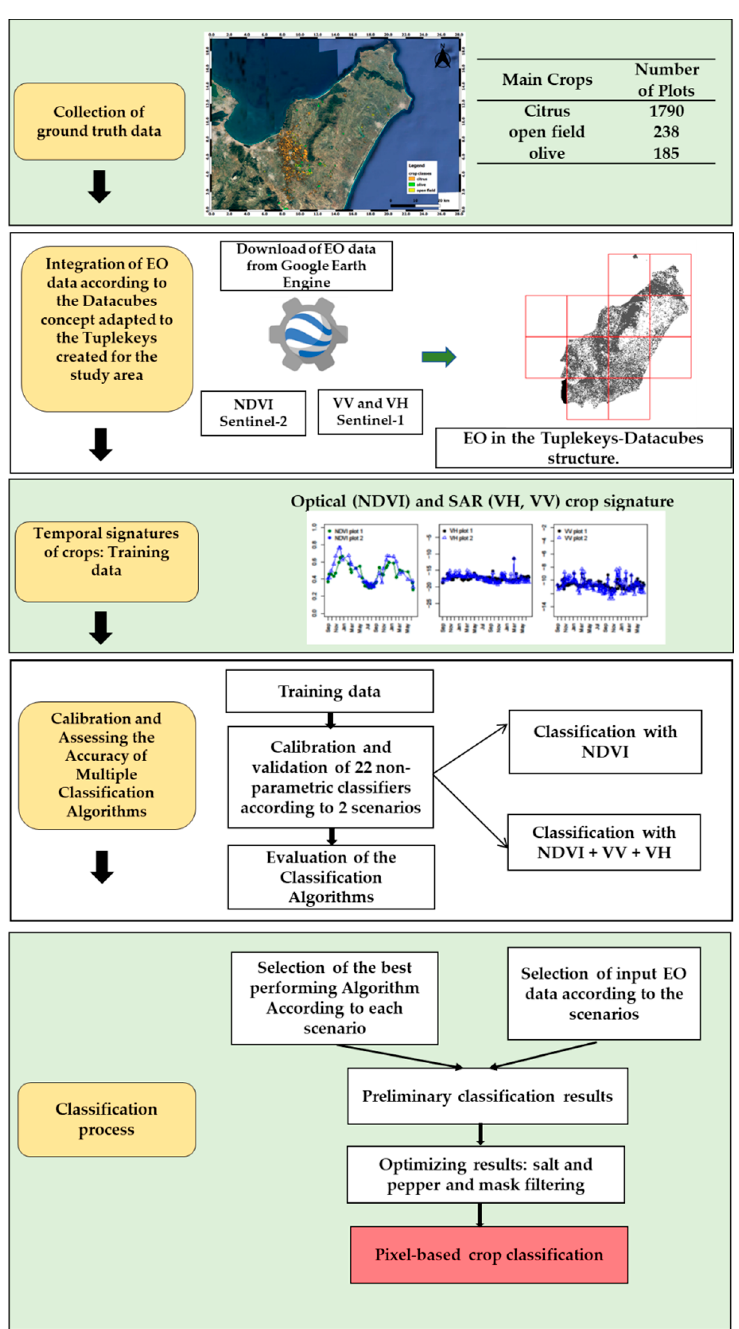
Figure 2. General workflow.